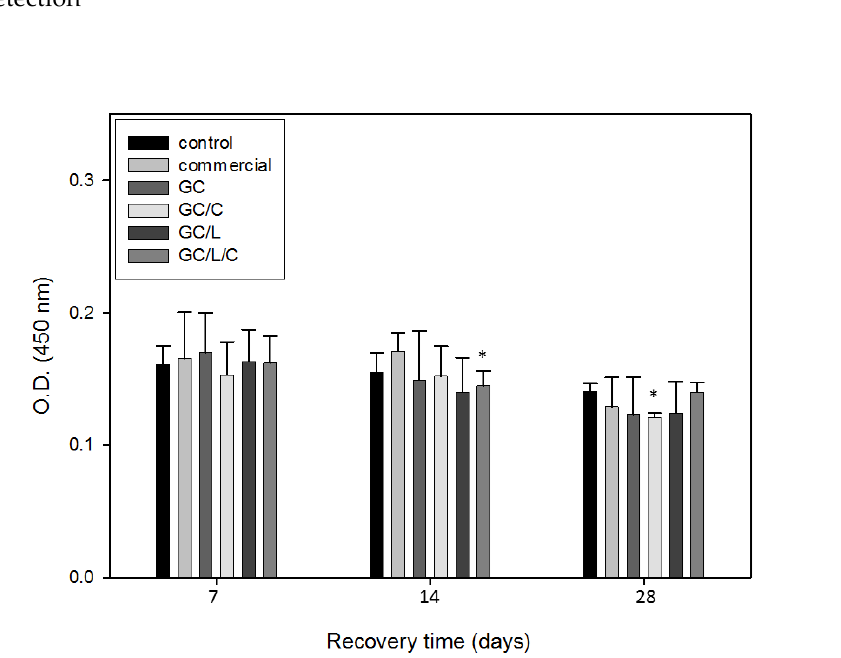
Figure 10. Comparisons of IL-6 ( A ) and TNF- α ( B ) level in diabetic rats treated with a GC, GC / L, GC / C, and GC / L / C sca ff olds, commercial (Comfeel ® ) or gauze (control) at seventh, 14th and 28th